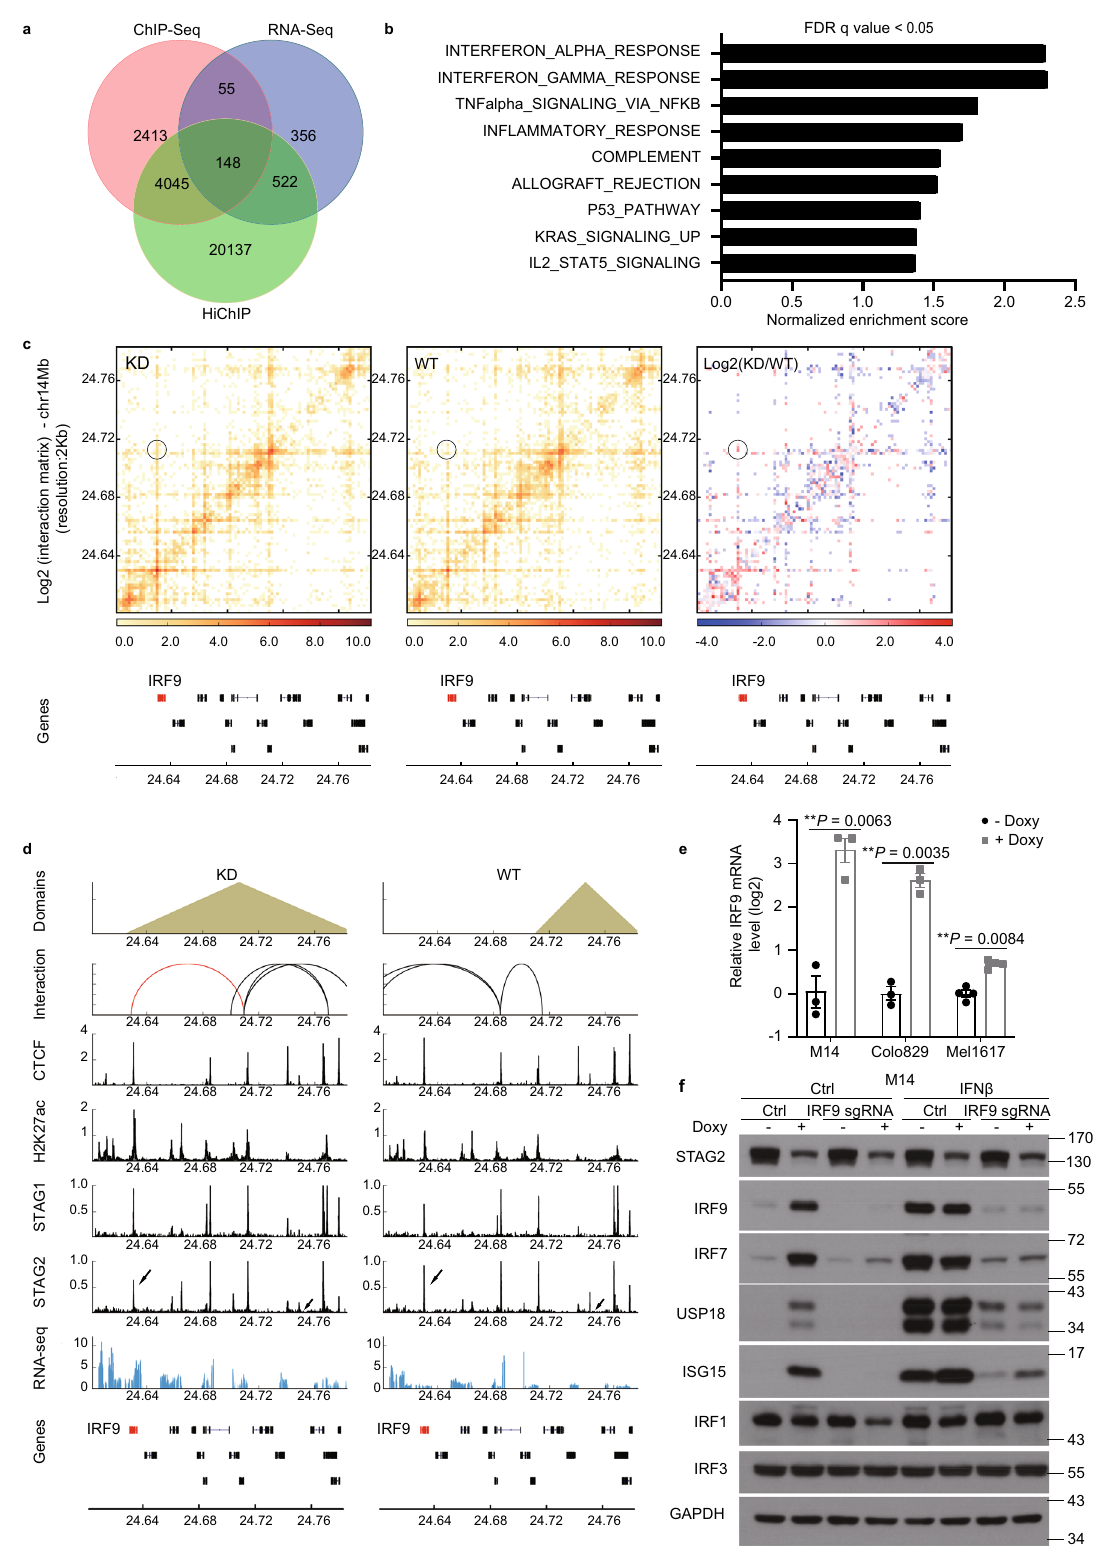
Discussion (Fig. 4m and Supplementary Fig. 10b) and longer progression- free survival (PFS) (two-sided KM log-rank test, p = 0.032) Our fi ndings here provide further insight into the role of (Fig. 4n), consistent with the hypothesis that tumors with STAG2 in the 3D genome organization and transcriptional upregulation of PD-L1 by STAG2 inactivation may be susceptible control. The regulation of promoter – enhancer interactions and to blockade of the PD-L1/PD-1 immune checkpoint pathway. TAD formation by the cohesin complex is well established 23 – 31 . NATURE COMMUNICATIONS| (2022) 13:1859